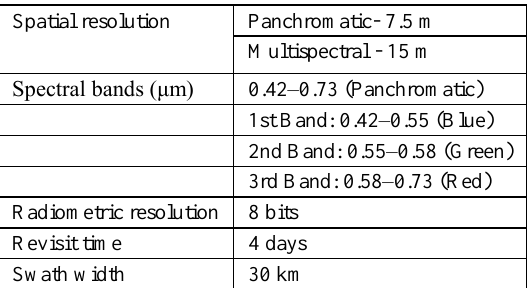
Table 1. Technical specifications of RASAT satellite